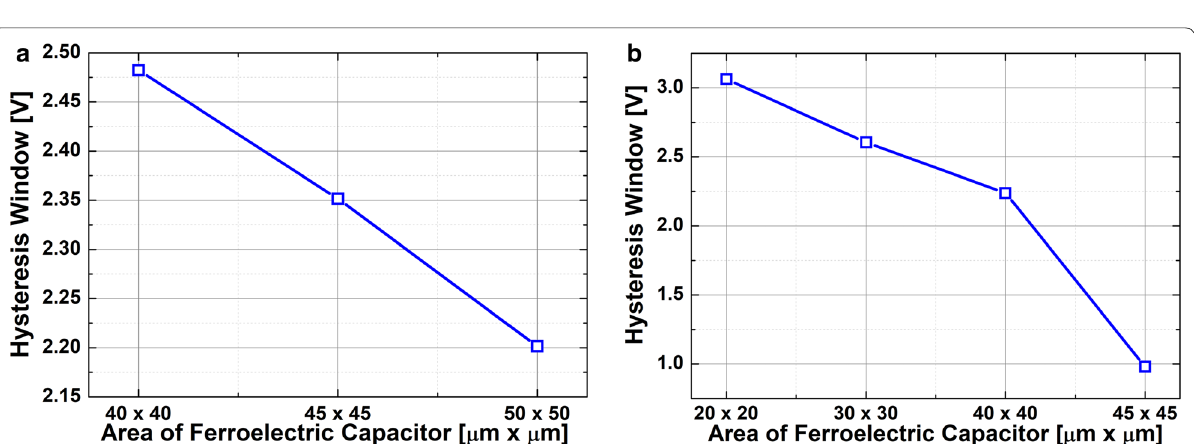
Fig. 5 Measured hysteresis window of a FE-FDSOI, b FE-FinFET vs. the area of ferroelectric